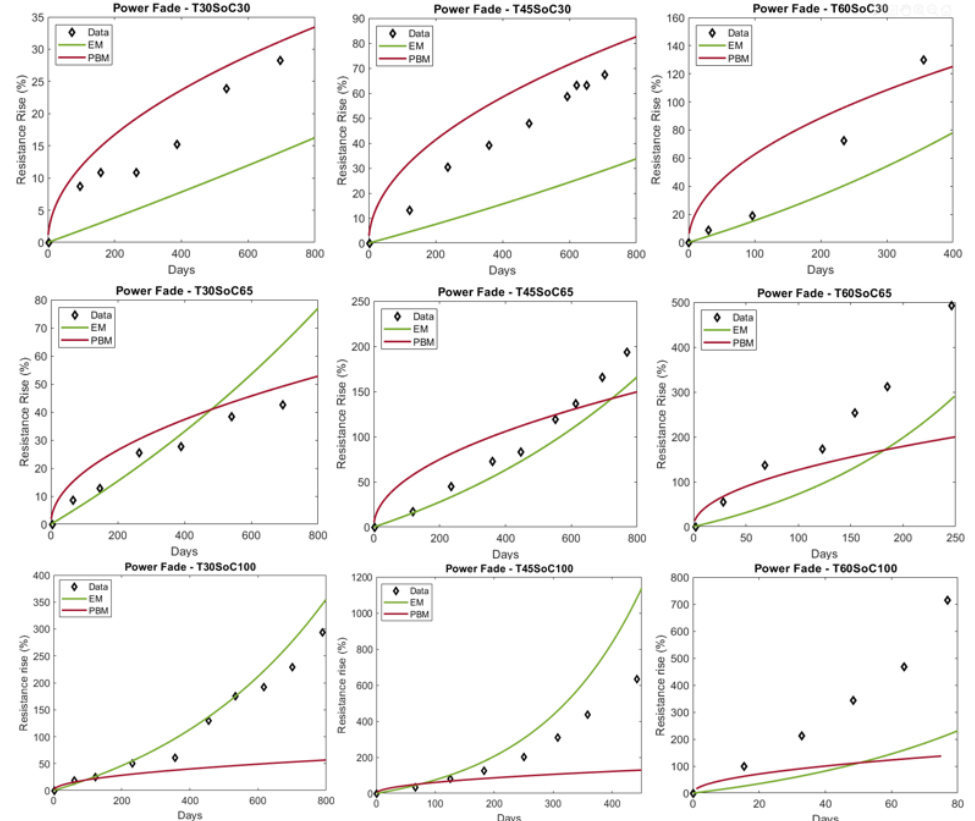
Figure 6. Comparison of resistance increase in calendar aging between aging data for the EM and PBM.